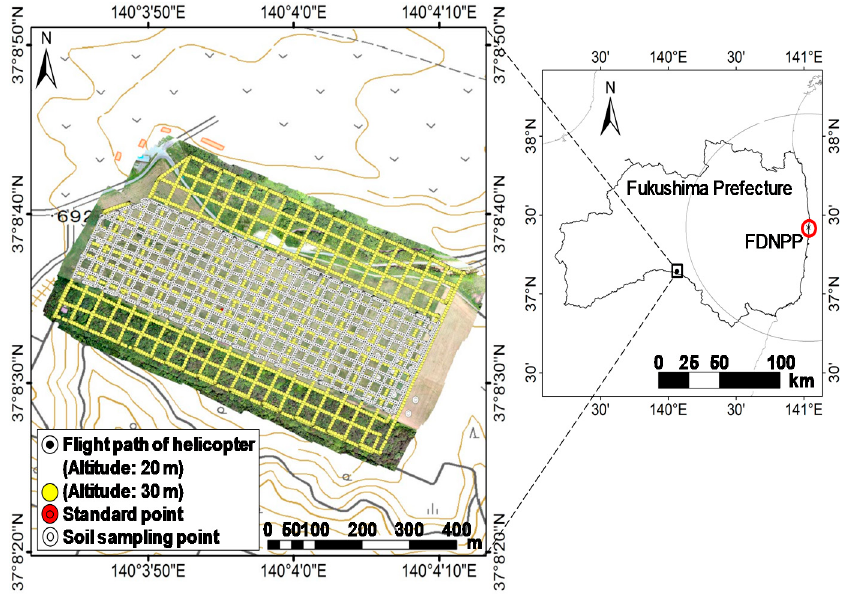
Figure 1. Location of the study site and measurement points. Yellow circles indicate the survey lines of ARM, and white circles indicate the soil sampling points.